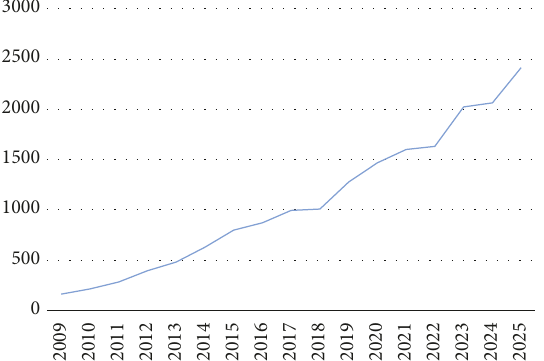
Figure 6: Solar energy supply in Portugal by year, gigawatts per hour. Source: IEA; author’s calculations.